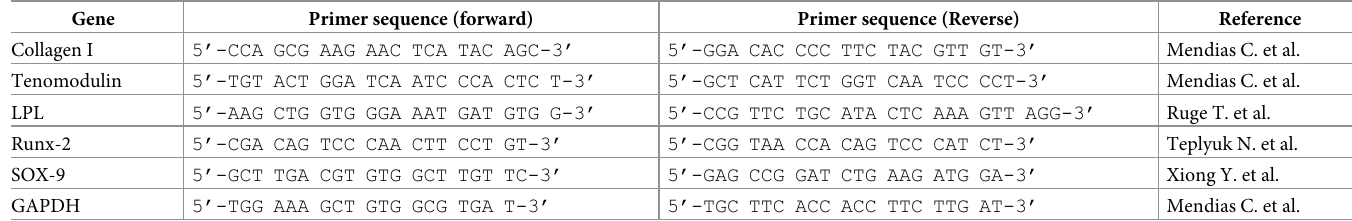
Table 1. Mouse primer sequences for qRT-PCR.